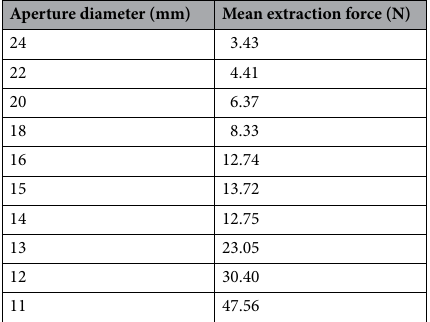
Table 1. Aperture diameter and force needed to extract the bag through the template.